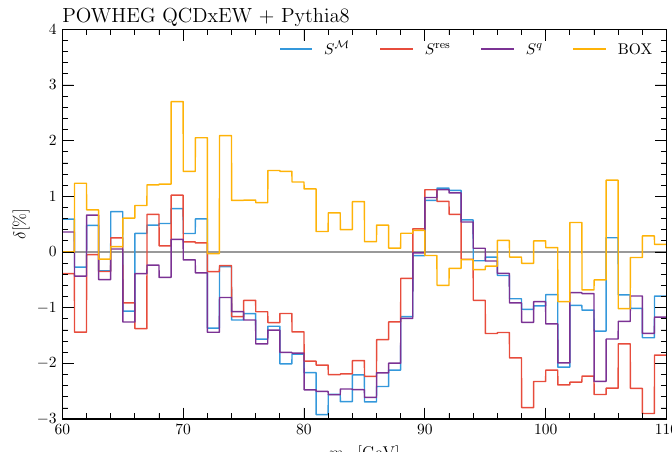
Figure 4 : Same as the lower plot in (cid:12)gure 3, but the relative di(cid:11)erences are shown with respect to the result obtained with S def . We show the results for the di(cid:11)erent resonace- improved S functions S res and S q along with S M and the result of the Powheg-Box